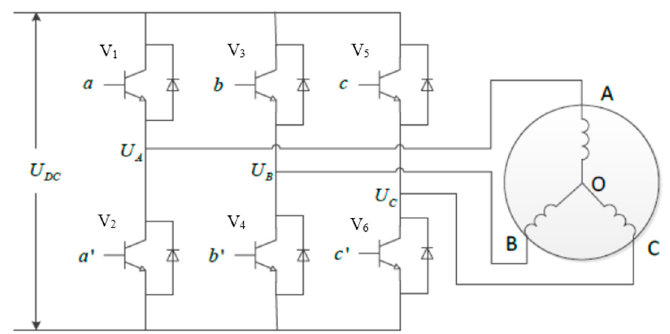
Figure 1. Upper power switch state.